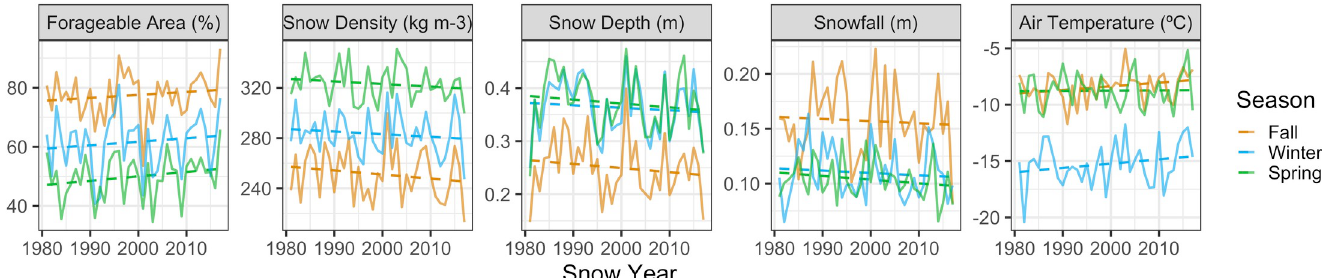
Fig 3. Time series and trends of each snow and climate covariate by season 1980 to 2017 within the Jacksina sheep survey unit within Wrangell-St. Elias National Park and Preserve, Alaska. Note the similar pattern of snow depth year-on-year across all three seasons and the close similarity of the mean snow depth in winter and